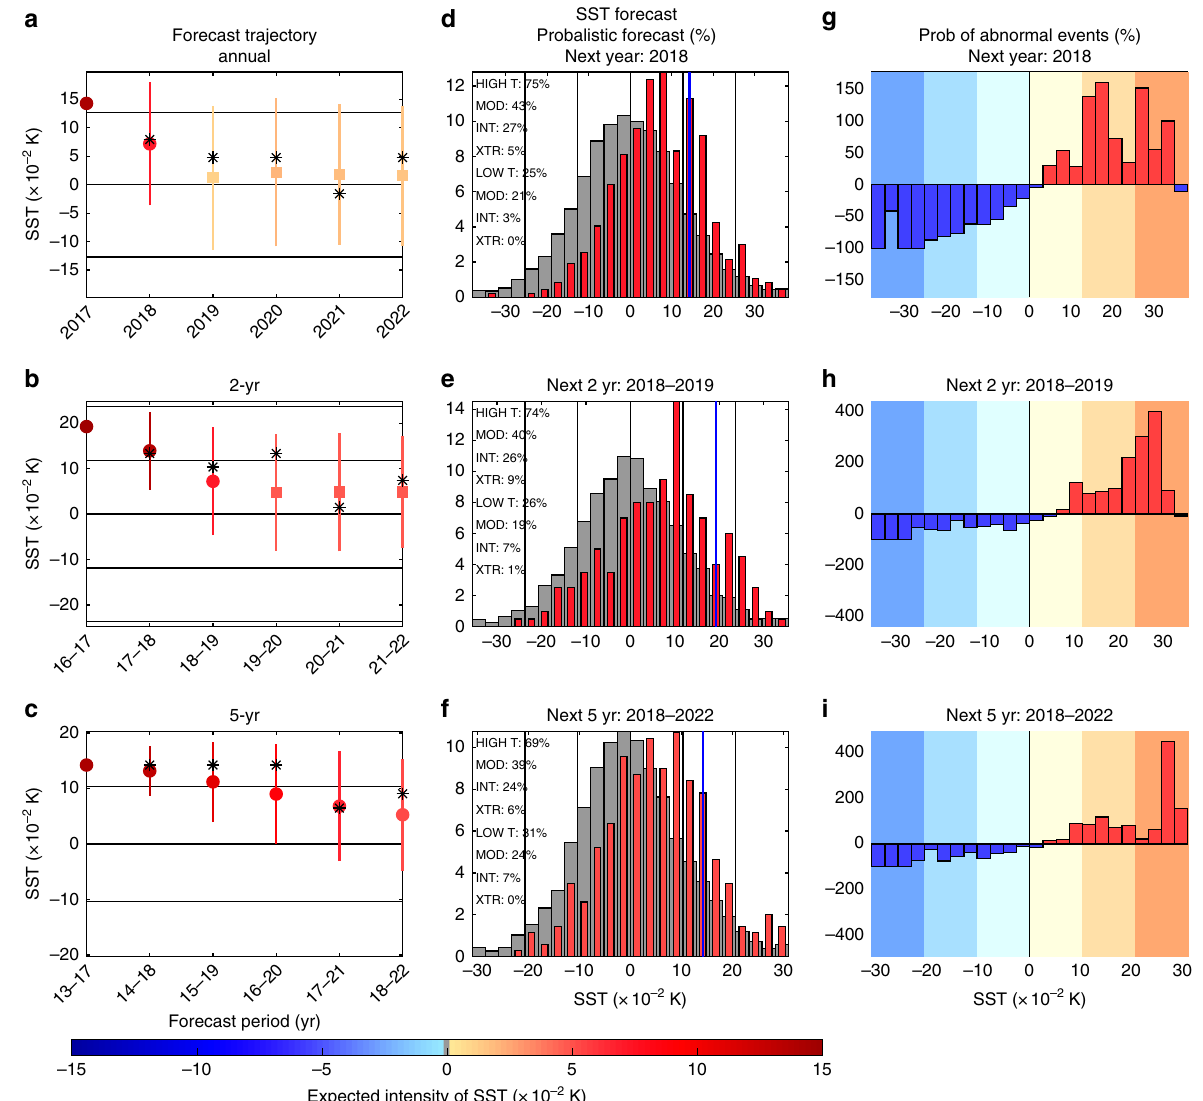
Fig. 8 Interannual probabilistic forecast of the SST anomalies. a – c Mean prediction of SST anomaly for the next 5 years for three different averaging times: annual, 2, and 5 years; horizontal black lines correspond to the mean, ±1, and ±2 standard deviations of the climatological distribution. Circles and squares represent mean predictions with coef fi cient of determination bigger and smaller than 0.2 (note that we still have good reliability even for skills smaller than 0.2); colorscale represents the mean prediction of the SST anomaly; the vertical colored lines represent ±1 standard deviation of prediction distributions. Stars denote the most likely state from the distributions. d – f Prediction of SST distribution (in %) for 1, 2, and 5 years in advance with respect to 2017. Gray histograms in the background represent the asymptotic, climatological distribution; vertical blue lines represent the current position used to initialize the forecast system; vertical black lines correspond to the mean, ±1, and ±2 standard deviations of the climatological distribution. g – i Distribution of probability anomaly (in %), probability changes with respect to the climatological distribution, for the 1, 2, and 5 years in advance predictions. Background colorscale represents ±0 – 1, 1 – 2, and more than 2 standard deviations, respectively, consistently with moderate, intense, and extreme